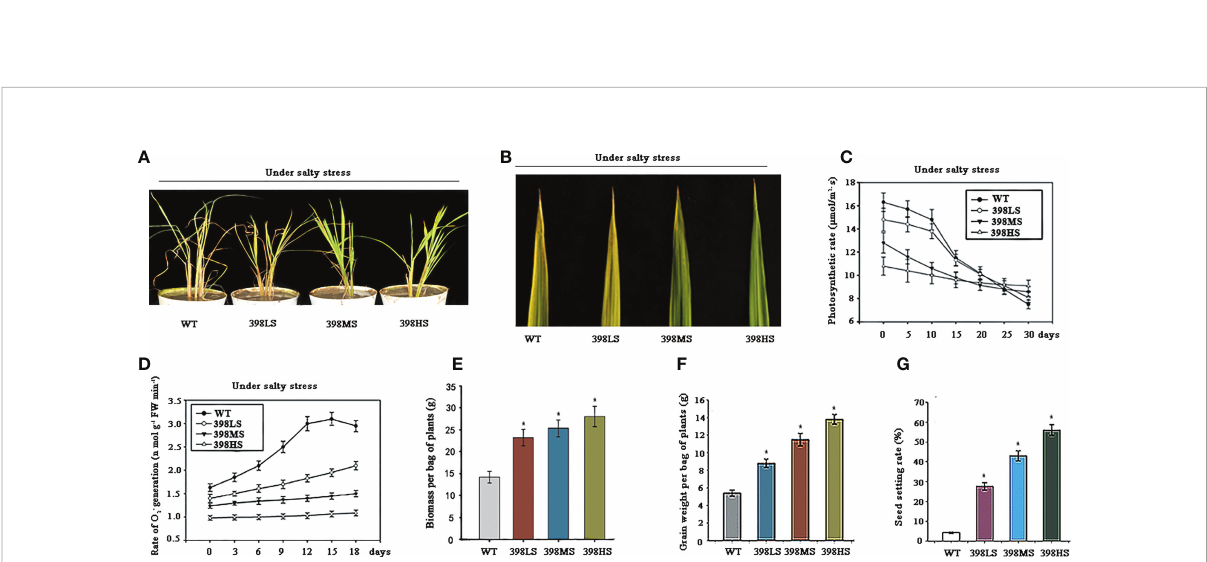
FIGURE 4 The growth traits of the three miR398 STTM lines under salt stress. (A) . The phenotypes of the three miR398 STTM lines under salt stress after one month of treatment. (B) . Phenotypes of the upmost leaf of the WT, 398LO, 398MO, and 398HO lines at the elongation stage. (C) . Time course of photosynthetic rate in the WT, 398LO, 398MO, 398HO under salt stress. The photosynthetic rates were measured by detecting CO 2 exchanging rate after being transplanted into salty soil. (D) . Changes of cellular O 2 – generation rates in the wild-type, 398LO, 398MO, and 398HO under salt stress. All data were the means of three independent measurements ± s.e. in Figure C and D (E) . Biomass per bag of plants of the WT, 398LS, 398MS, and 398HS at the mature stage. (F) . Grain weight per bag of plants of the wild-type, 398LS, 398MS, and 398HS after harvest. (G) . Seed setting rates of the WT, 398LO, 398MO, and 398HO at the mature stage. Asterisks indicate signi fi cant difference at P ≤ 0.05 compared with the wild-type by Student ’ s t test (n = 3; means ± SD) in the Figure E, F, and G.